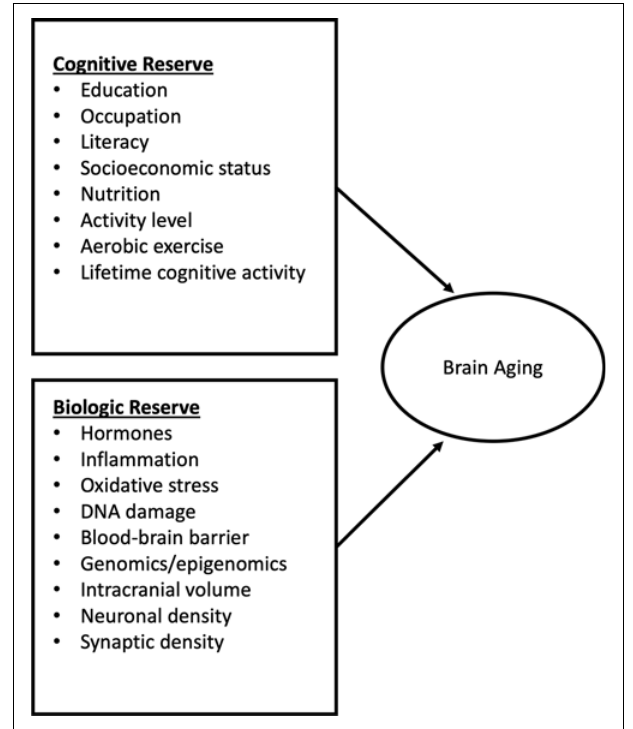
FIGURE 2 | Influences of cognitive and brain reserve on brain